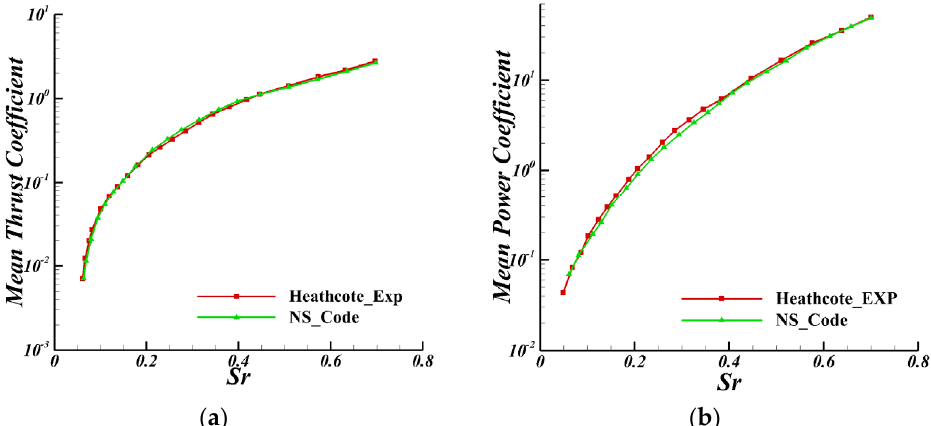
Figure 3. The mean thrust coefficient, mean power coefficient as a function of Strouhal number; pure plunging motion (h = 0.175). ( a ) Mean thrust coefficient. ( b ) Mean power coefficient.